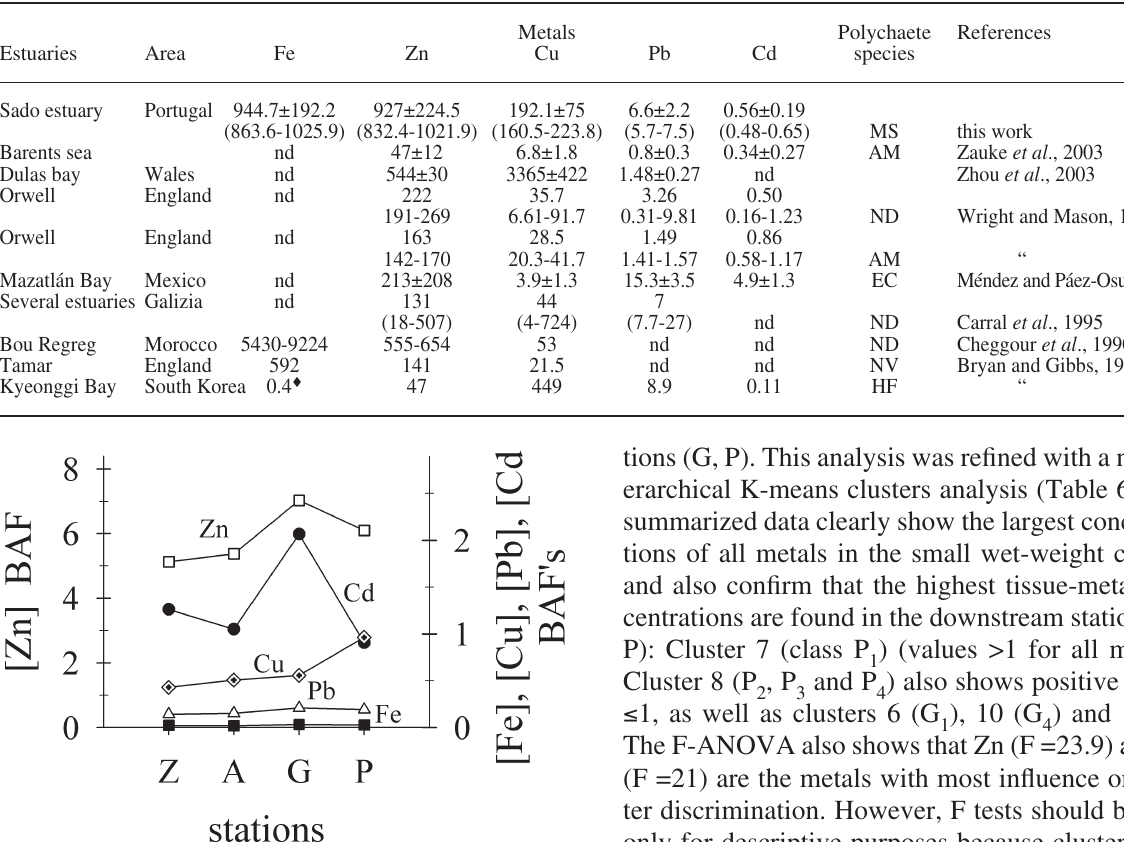
Table 5. – Metal concentration (µg g -1 d.w.) averaged over the whole populations and standard deviation (±sd) in Marphysa sanguinea (Ms) compared with metal concentrations in arenicola marina (aM); nereis diversicolor (nD); nereis virens (nV); heteromastus filiformes (HF) and eurythoe complanata (ec) in several polluted estuary environments. the 95% confidence intervals are shown in brackets; ♦ (% value); nd, not determined.